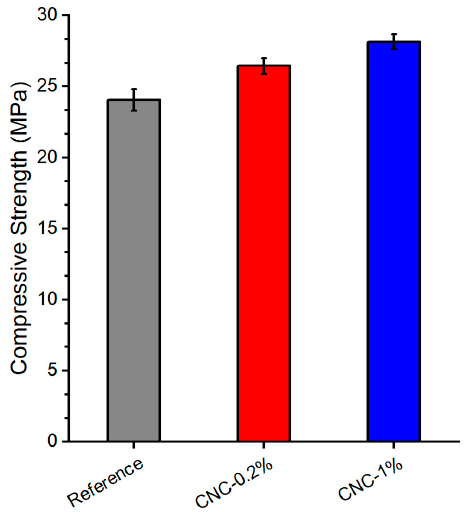
Figure 1. E ff ect of CNCs % on compressive Figure 1. Effect of CNCs % on compressive strength.